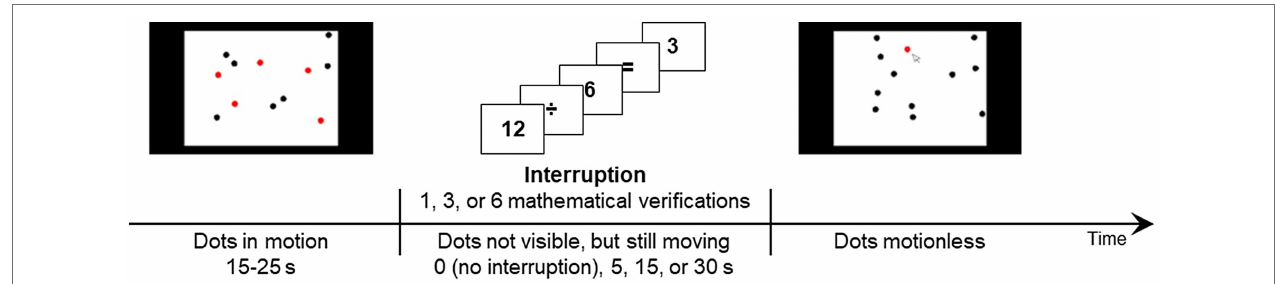
FIGURE 1 | Schematic representation of the multiple object tracking task. The left part of the timeline represents the visible part of the movement phase. The middle part depicts the execution of the interrupting task (if any), during which the dots continued their trajectories despite not being visible. The right part of the timeline represents the response phase, in which all dots turned black and participants had to select those they thought were the